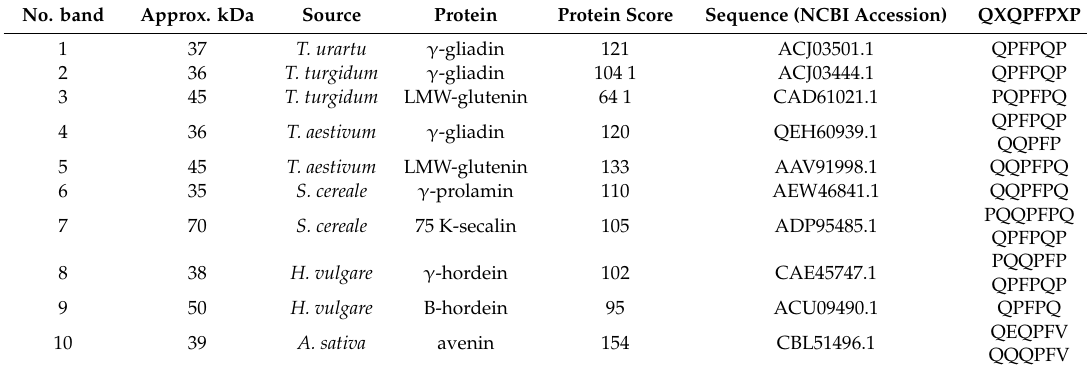
1 proteins identified using ‘ion score’ option.